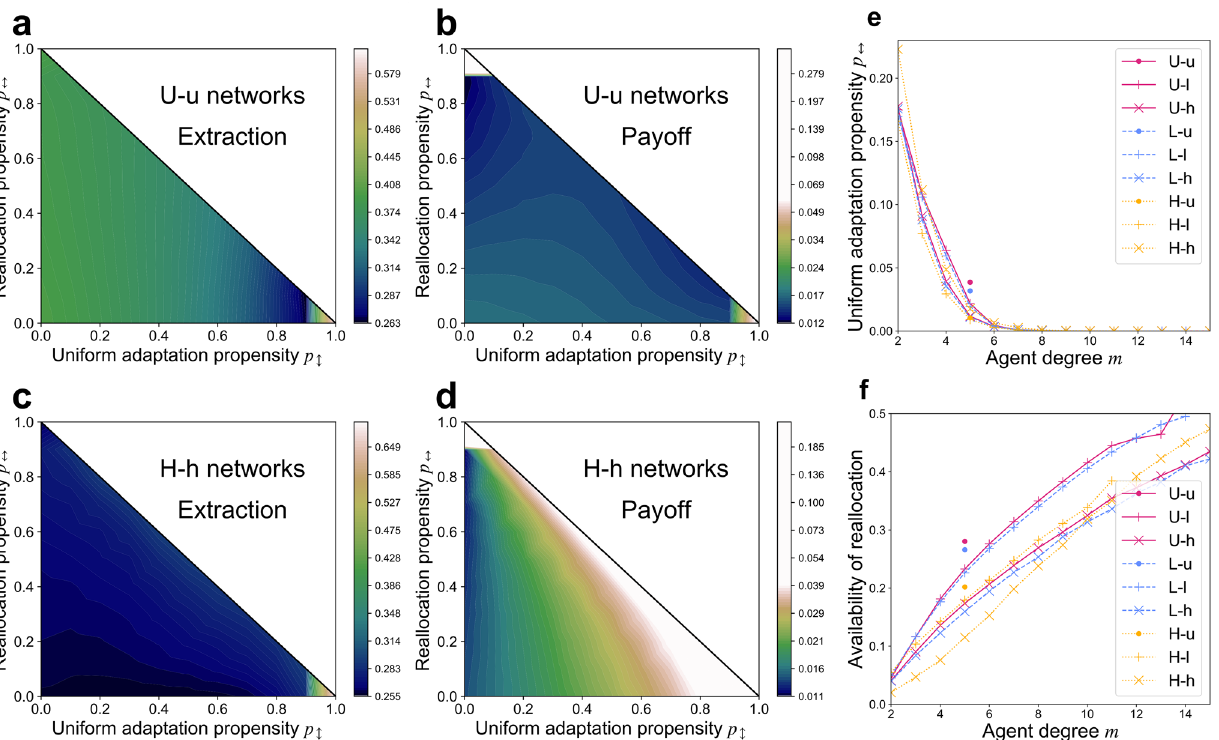
Figure 4. Mixed adaptation strategies. Contour plots interpolating mean values from simulations on ensembles of 30 networks, with data points at increments of .1 in p (cid:31) and p ↔ , with p 0 = 1 − p � − p ↔ (The origin ( ( p � , p ↔ ) = ( 0, 0 ) ) represents pure free adaptation , the rightmost corner ( p � , p ↔ ) = ( 1, 0 ) represents pure uniform adaptation , and the upper corner ( p � , p ↔ ) = ( 0, 1 ) represents pure reallocation ): ( a ) Extraction effort from uniform-degree (U-u) networks; ( b ) Payoffs from uniform-degree (U-u) networks; ( c ) Extraction effort from high degree-heterogeneity (H–h) networks; and ( d ) Payoffs from high degree heterogeneity (H–h) networks. Reinforcement learning: Means over ensembles of 300 networks of each type of ( e ) Uniform adaptation propensity by agent degree, and ( f ) Availability of reallocation (the fraction of iterations in which an agent finds itself in a mixed-quality environment containing at least one each of viable and depleted